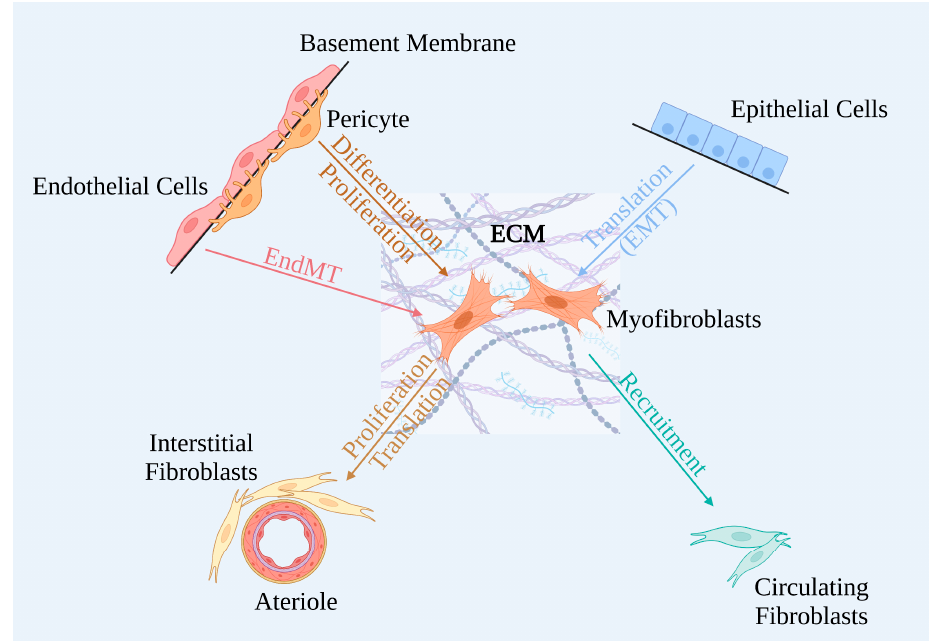
Figure 3. Features of myofibroblast